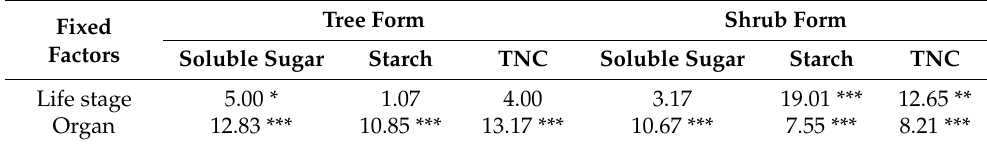
Table 3. Mixed linear model results of tree and shrub growth forms for factors affecting NSC concentration. In each growth form, the NSC concentration was used as the dependent variable, life stage, and organs were used as fixed factors. Different individuals were used as random